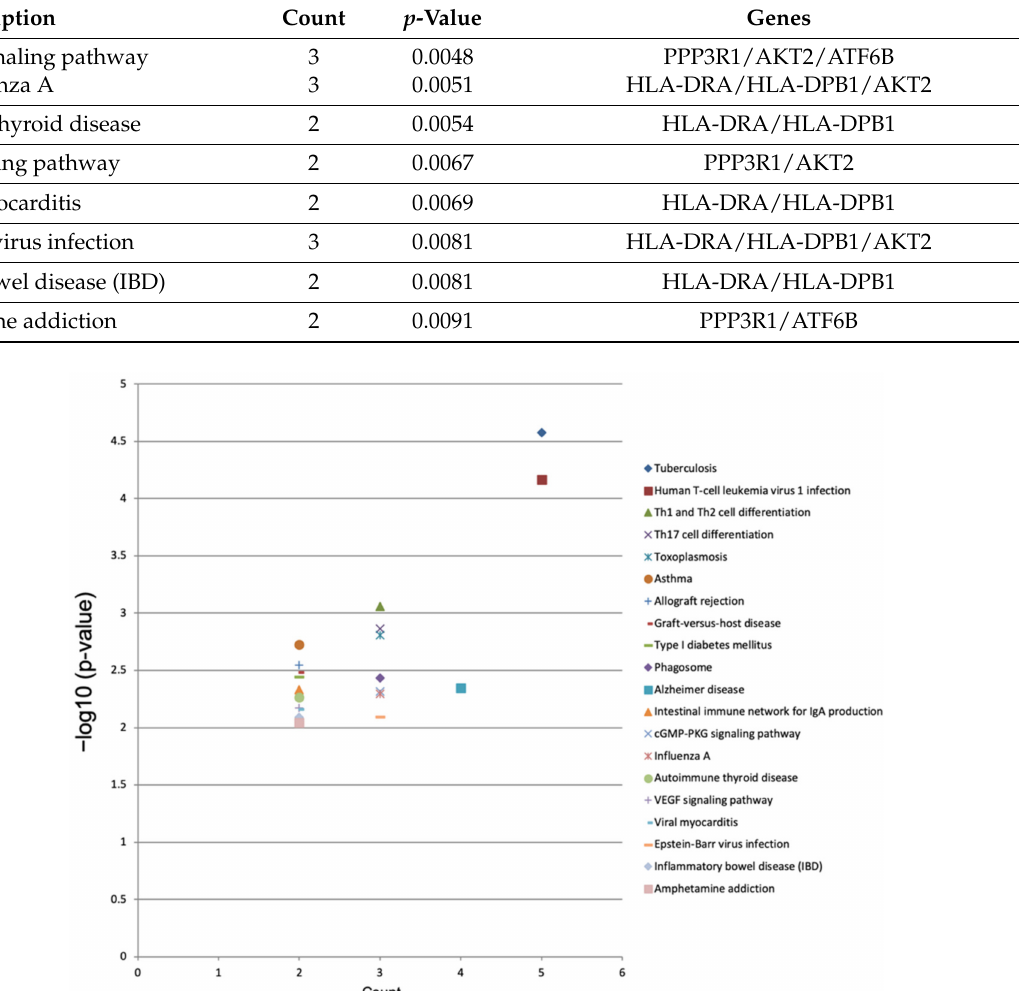
Figure 7. KEGG pathway enrichment analysis of differentially expressed genes in luteolin-treated cells. In the image, the top 20 KEGG pathways with − log10 ( p value) and multiple enrichment are plotted. A higher fold enrichment value and − log10 ( p value) indicate that the expression level of the pathway is higher and more